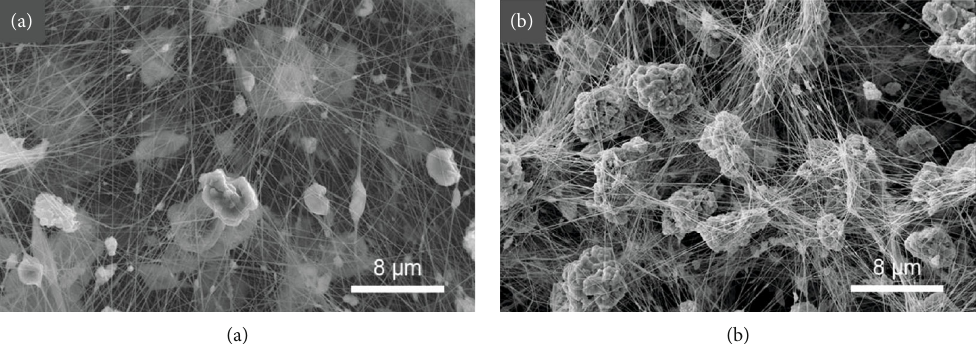
Figure 7: SEM images of electrospun nano fi bers of (a) collagen/HA and (b) collagen/oHA. Inorganic particles mineralize within the nano fi bers, promoted by the presence of oHA. The pattern of mineralization gave rise to a change in pore size which, in turn, enhances cell migration and proliferation within the voids. These fi gures have been reproduced with permission from Elsevier